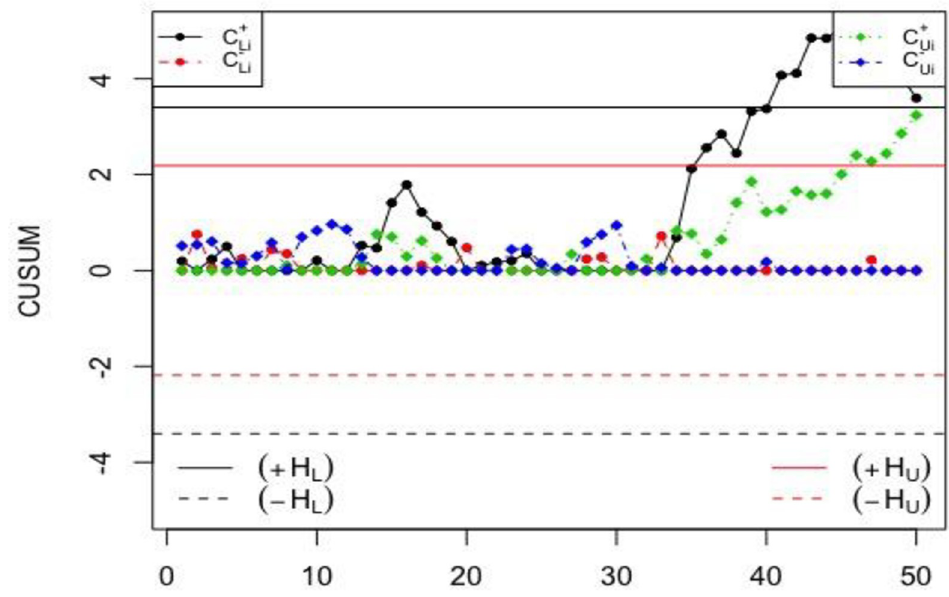
Fig 1. The proposed NCUSUM � X chart for simulated dataset.